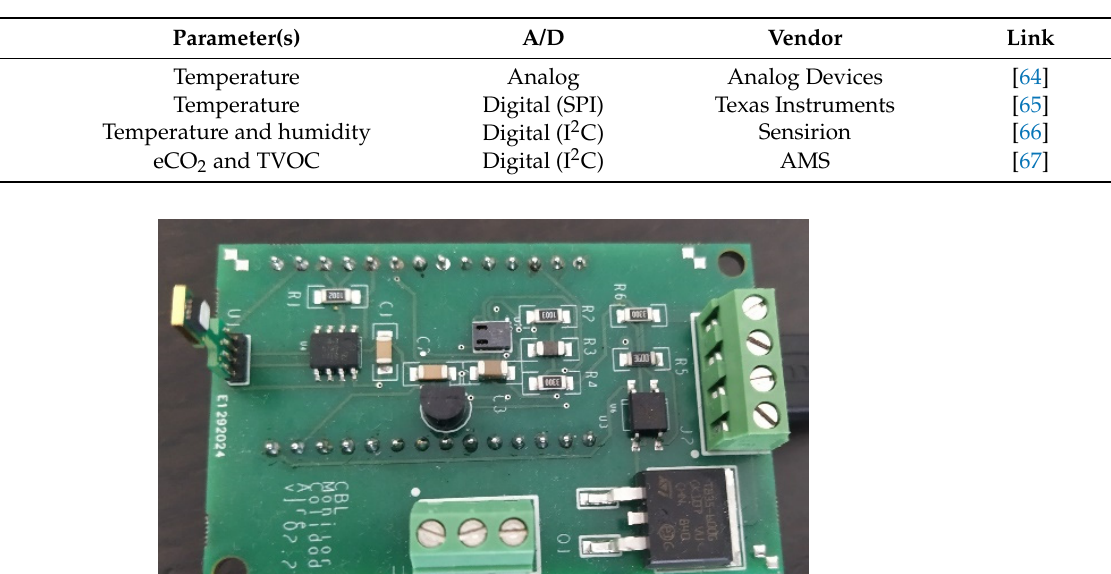
Table 3. List of sensors at the prototype.